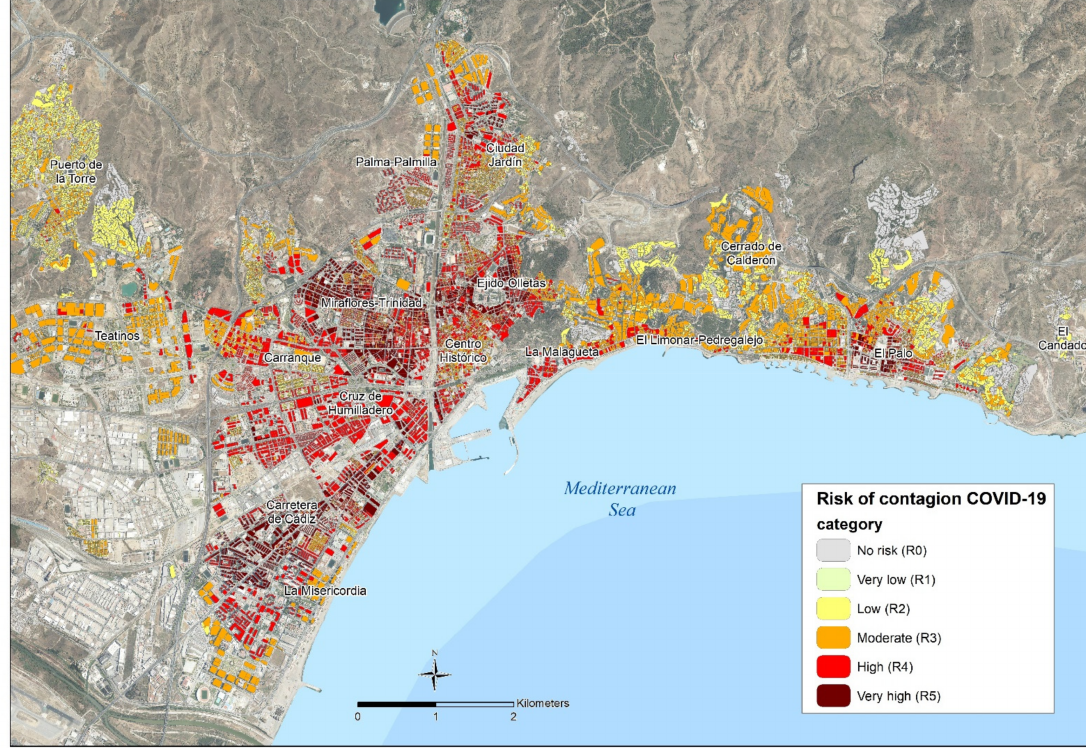
Figure 12. Risk of contagion map. Own